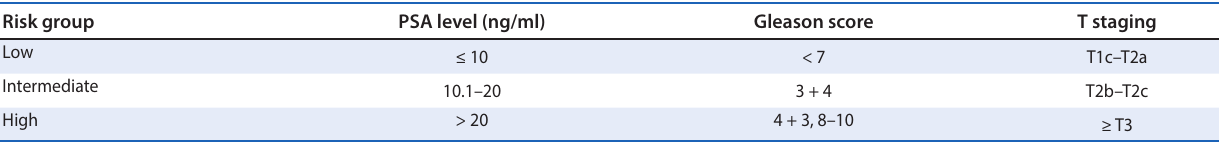
Table 1: Risk group stratification by PSA level, Gleason score, and T staging Risk